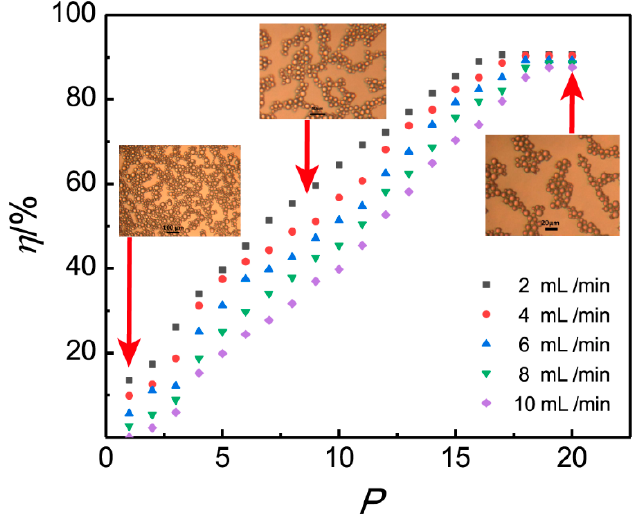
Figure 5. Influence of the plate number on the demulsification efficiency.